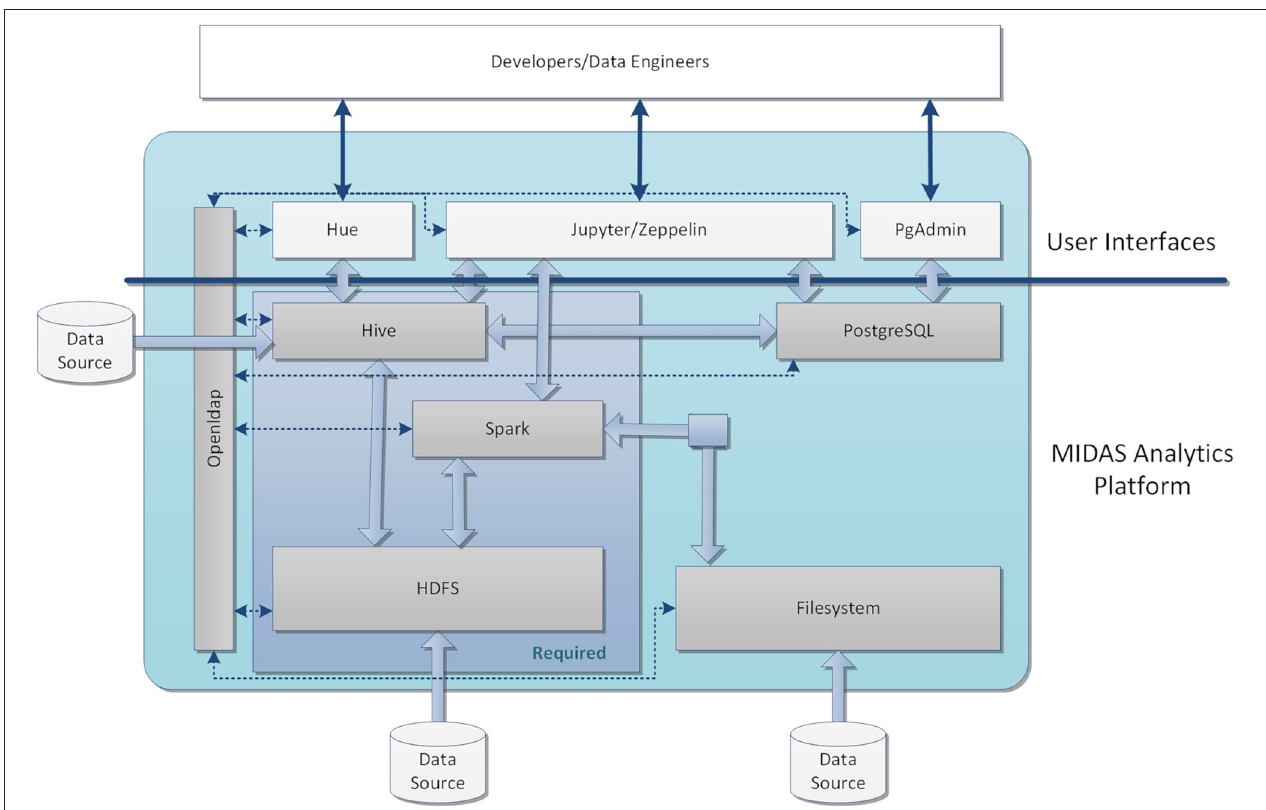
FIGURE 2 | An overview of the system configured for MIDAS. The core data platform for the MIDAS stack was based on HDFS, Hive, and Spark. The data can be imported into the system through Filesystem, HDFS, or externally to Hive. HDFS was applied to store files and raw data and Hive was employed as a data warehouse for the structured data after processing. External data assets were also virtualized through the Hive interface and they could be accessed by the MIDAS tools similarly to locally loaded data assets and used within GYDRA. The UI of the analytic platform includes Jupyter Notebook with Python and PySpark for developing and testing the underlying analytics models before being implemented within the MIDAS Analytics Backend. For managing and querying the databases in Hive and PostgreSql, an open sourced interactive editor Hue was used, and Zeppelin provided support for running Spark applications. User access was managed by a local LDAP server, which provided role-based access to the user applications and underlying data stores. © [2021] IEEE. Reprinted, with permission, from (